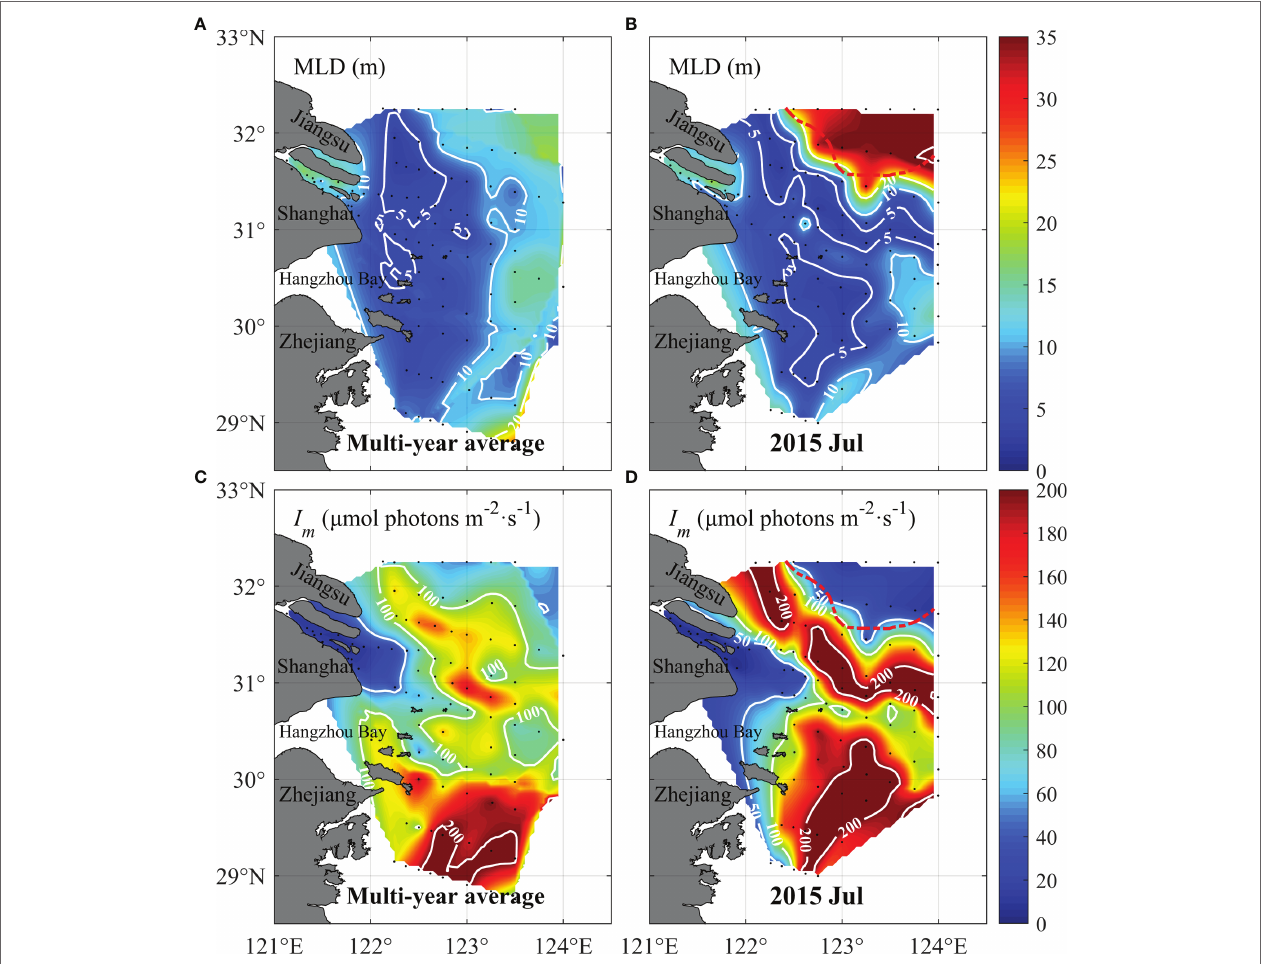
FIGURE 9 | Spatial distributions of the mixed layer depth (MLD, A , B ) and vertically averaged irradiance in the mixing layer ( I m , C, D ) of multi-year average (2013– 2018) and 2015. The black line represents the plume front. The red line is the boundary of the CWZ.